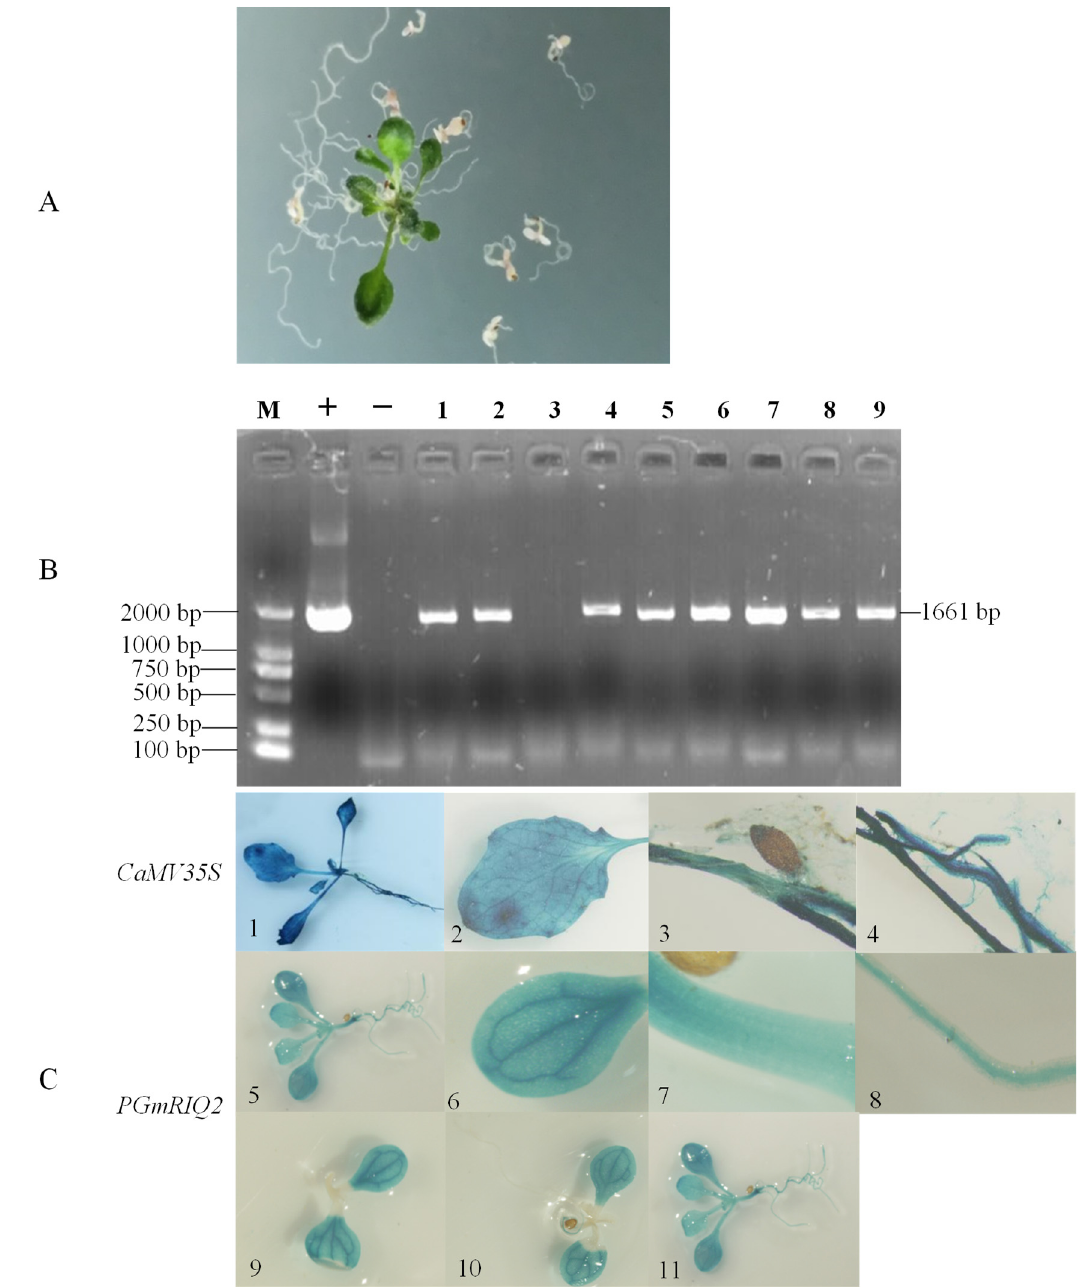
Figure 6. Detection of transgenic Arabidopsis with the full-length promoter of the GmRIQ2 gene and GUS staining. ( A ) 5 mg/L PPT resistance screening. ( B ), PCR detection. M: DNA marker (DL2000);